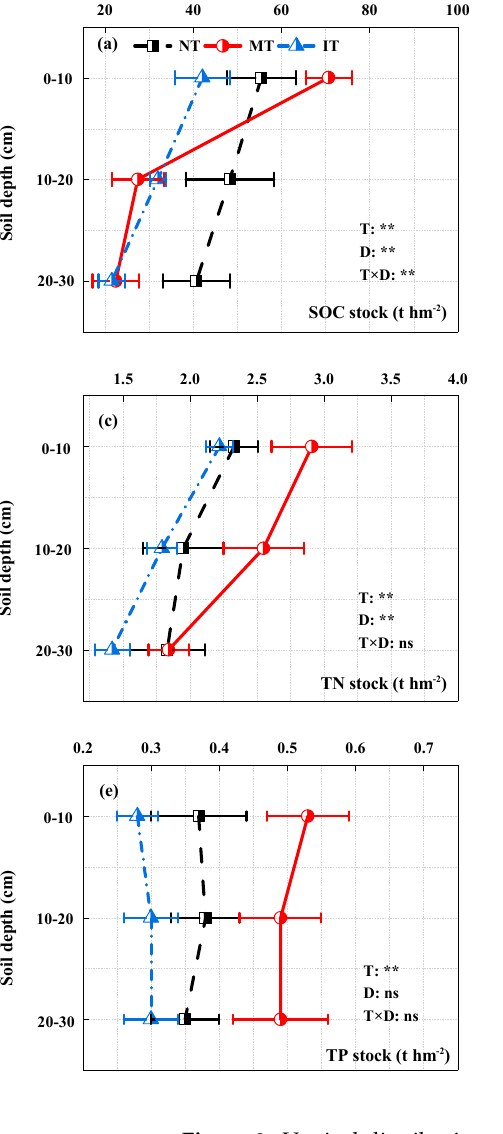
Figure 3. Vertical distribution stocks of soil organic carbon (SOC) ( a , b ), total nitrogen (TN) ( c , d ), and total phosphorus (TP) ( e , f ) (mean ± SD, n = 3) in the 0–30 cm soil profile for the no-thinning control (NT), moderate thinning (MT), and intensive thinning (IT), respectively. Significant differences between thinning treatments (T), soil depths (D), and their interactions are shown at **, p < 0.01; and ns, p > 0.05. Different capital letters (A, B, and C) indicate significant differences between the same thinning treatment and different depths ( p < 0.05); different capital (D, E, and F) and lowercase letters (a,b) indicate significant differences among different thinning treatments in the total soil profile (30 cm) and each 10 cm layer with corresponding soil layers ( p < 0.05), respectively.